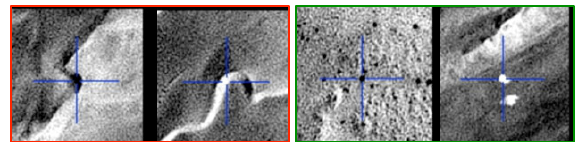
Figure 8. Feature points on desert: dunes (red) and other (green) A method based on a deep learning classification algorithm has been developed to automatically detect dune points, and was applied on the Rub’ al Khali desert. A training dataset of 5122 samples was built up manually (representing 1,8% of the entire dataset) and used in a typical convolutional neural network based on VGG16 (Simonyan, K., Zisserman, A, 2014). For each point, the algorithm provides a probability of belonging to a given class. To ensure the best reliability, the 9% of the points classified with a low confidence were shown to an operator for review. Quality control, conducted on a randomly selected subset of 25,084 points all over the area, shows 10% errors.